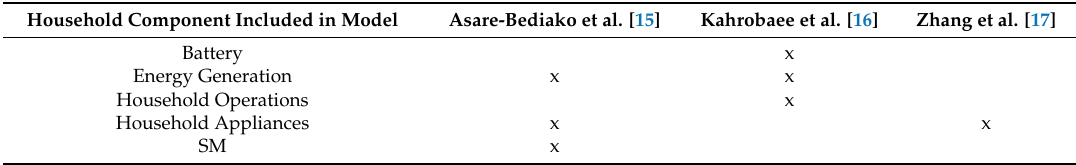
Table 2. Related work: household simulation